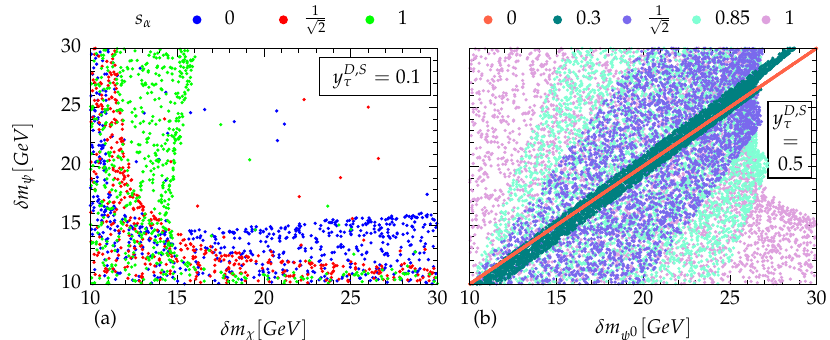
Figure 5 . Correlations δm χ vs δm ψ in figure 5(a) and δm ψ vs δm ψ in figure 5(b) for relic density 0 allowed points as a function of the mixing angle. Since all other parameters are the same for the dark leptons discussed in each plot, it is only up to the mixing parameter to determine the dominant relic density contribution between them. The DM mass varies in the range 65 GeV ≤ m φ ≤ 1